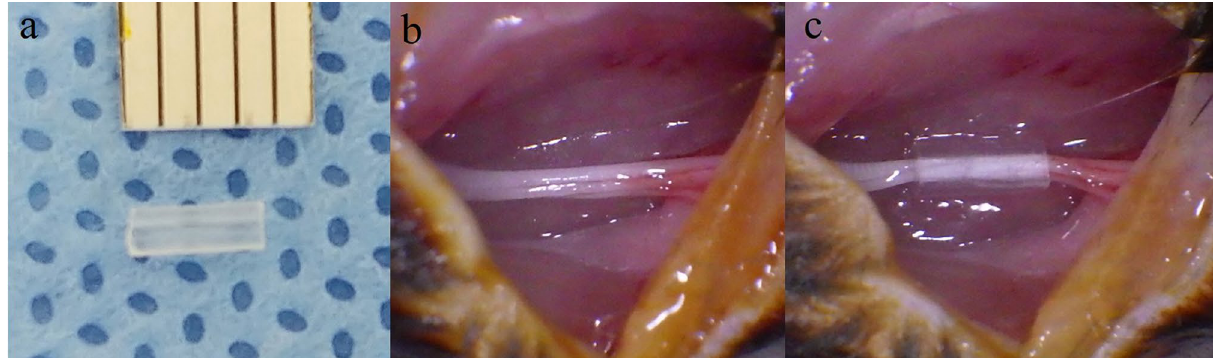
Figure 5. A murine model of compression neuropathy. A 3-mm length of a biologically inert silicone tube ( a , inner diameter 0.4 mm) is placed around the sciatic nerve ( b ), providing a model of compressive neuropathy ( c